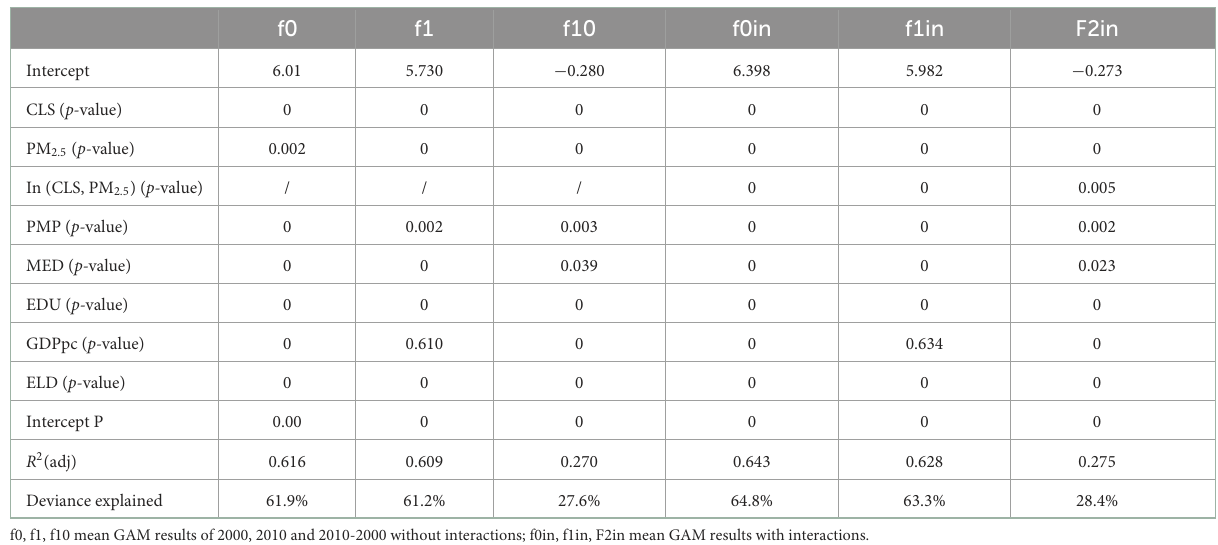
TABLE 2 The parameters for GAM in two periods with interactions.